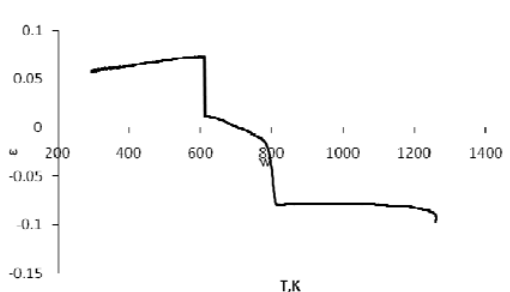
Fig.4. Difference in the strains upon heating and cooling as a function of temperature.